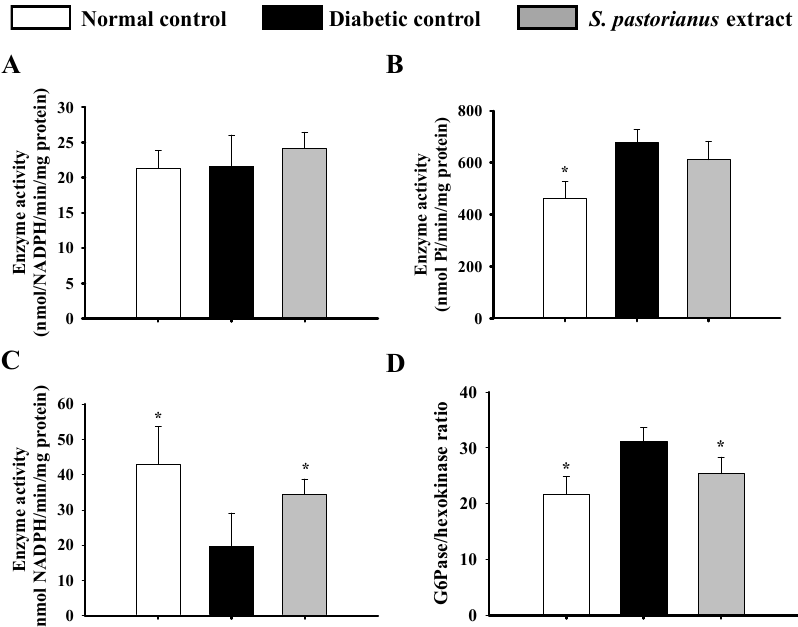
Figure 3. The carbohydrate metabolism enzymes activities in liver of diabetic rats treated with S. pastorianus extract. The rats were injected with nicotinamide and streptozotocin for the induction of diabetes and fed with S. pastorianus extract for 6 weeks as described in Materials and Methods. After sacrifice, the liver samples were harvested for the detection of ( A ) hexokinase, ( B ) glucose-6-phosphatase (G6Pase), ( C ) glucose-6-phosphate dehydrogenase (G6PD), and the ratio of G6Pase/hexokinase ( D ) activities. Results are expressed as mean ± SD for each group of rats ( n = 8). * p < 0.05 compared with diabetic